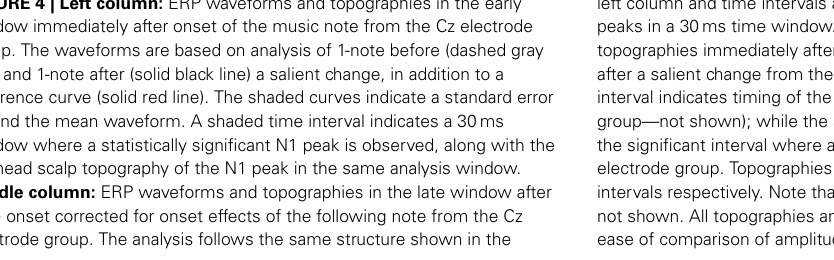
left column and time intervals and topographies indicate significant P300 peaks in a 30ms time window. Right column: ERP waveforms and topographies immediately after onset from analysis of 3-notes before and after a salient change from the Fz electrode group. The first significant time interval indicates timing of the P1 peak (analyzed from the Cz electrode group—not shown); while the second time interval around 160ms indicates the significant interval where an MMN-like component is observed in the Fz electrode group. Topographies shown correspond to the P1 and MMN intervals respectively. Note that non-significant intervals and topographies are not shown. All topographies and waveforms are kept to the same scale for ease of comparison of